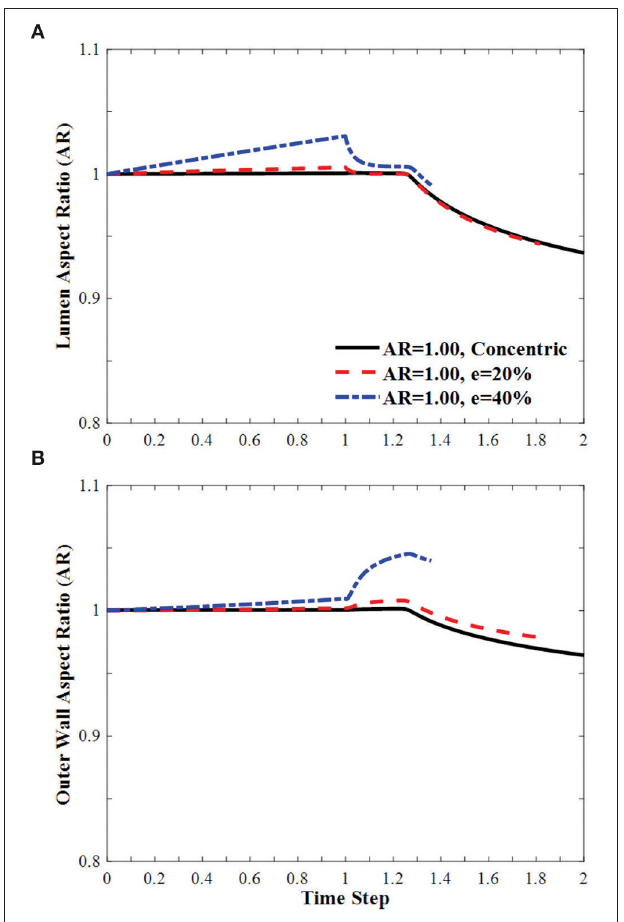
FIGURE 7 | Effect of eccentricity on the AR of the (A) lumen and (B) the outer wall of circular arteries (initial AR = 1) during the axial stretch and lumen pressure loading process. Initial eccentricity (e) of 0% (concentric), 20 and 40% in the direction opposite to the direction of deflection is compared. The AR is calculated as the ratio of diameter in the buckling direction vs. the diameter in the direction vertical to the buckling direction. Time step is the same as in Figure 3 .